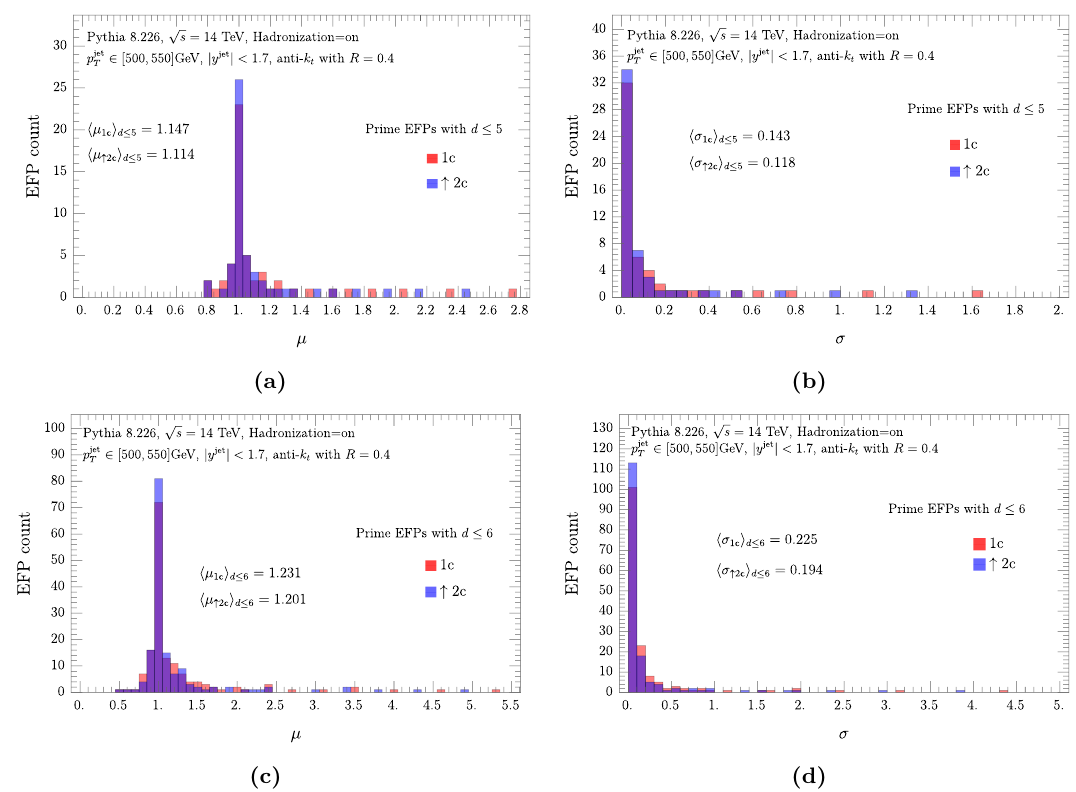
Figure 8. Histogram for the average µ (left) and standard deviation σ (right) of the ratio between prime EFPs and their expression in terms of basis elements in the 1- (red) and 2-collinear (blue) approximation. Going from EFPs up to degree 5 (top) to degree 6 (bottom), µ and σ become slightly worse because of a couple of outliers, which are star-like